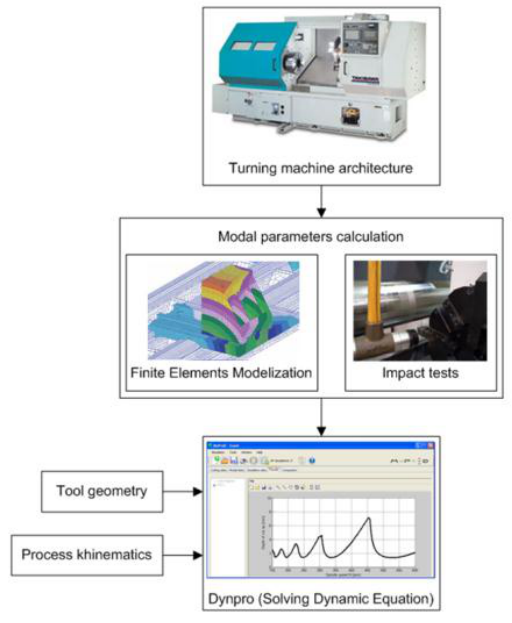
Figure 10. Experimental procedure for improved dynamic performance.